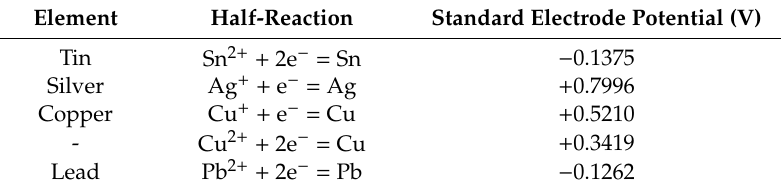
Table 1. Reactionsandstandardelectrodepotentialsoftheelementsintin–silver–copper(SAC)solders[71]. Element